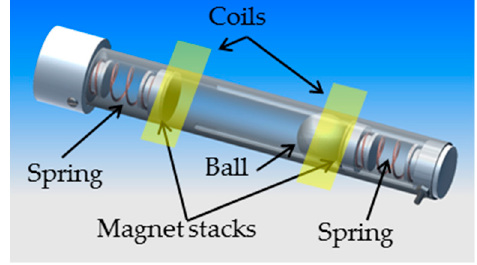
Figure 1. Schematic drawing of the hollow cylinder.